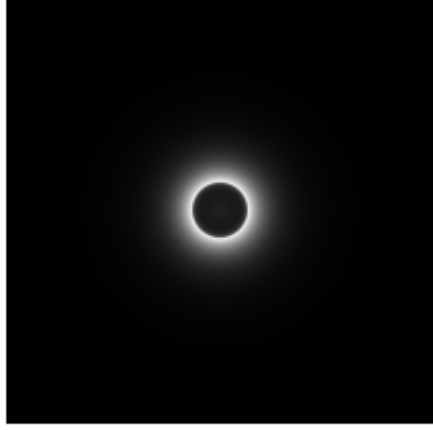
Figure 6. Halo Figure 6. Halo function.